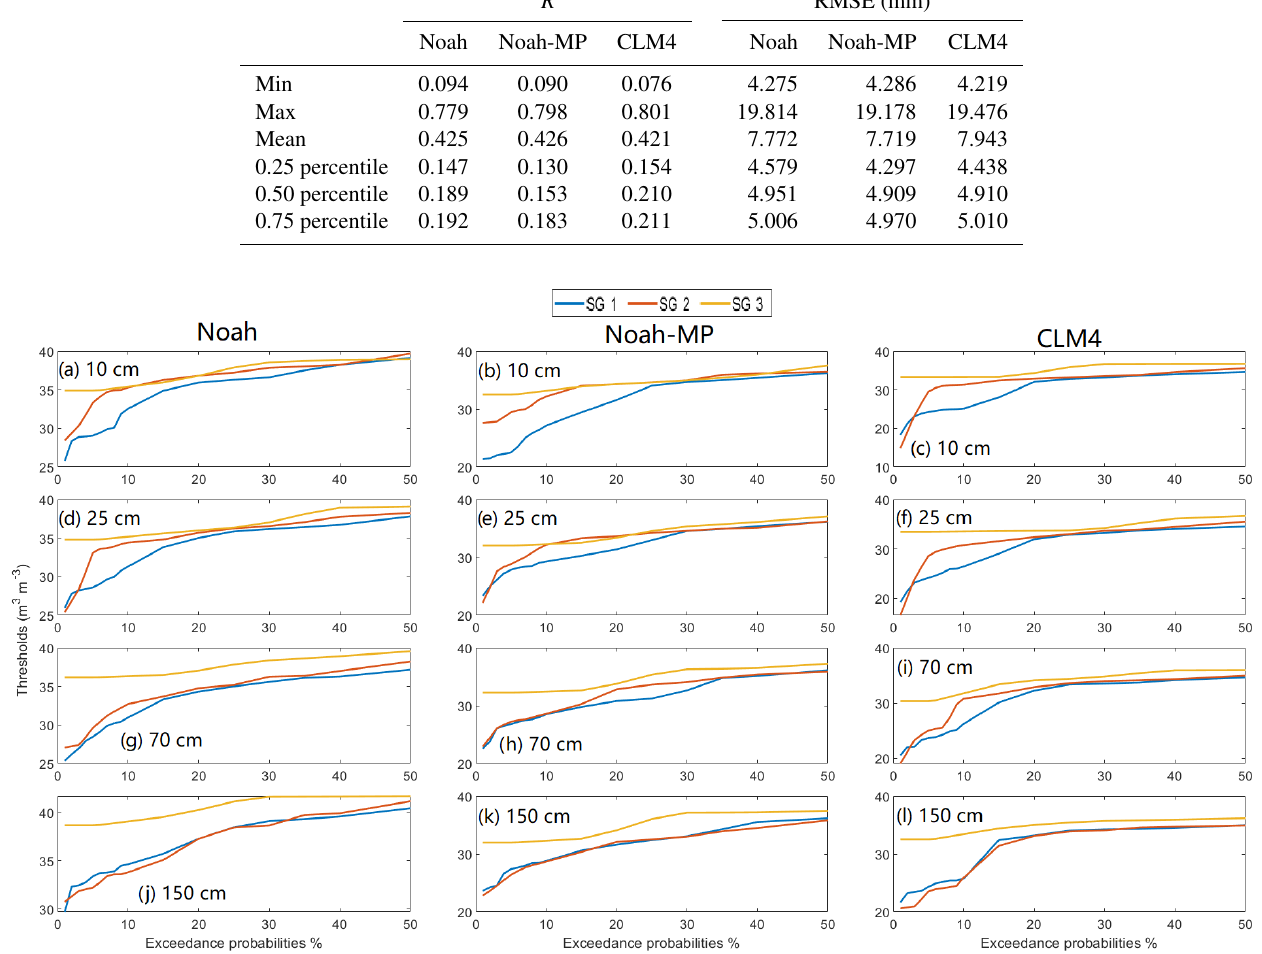
Figure 7. Threshold plots. For Noah (a, d, g, j) , Noah-MP (b, e, h, k) , and CLM4 (c, f, i, l) land surface schemes under three slope angle groups (SGs), with SG 1 = 0.4–1.86 ◦ , SG 2 = 1.87–9.61 ◦ , SG 3 = 9.52–40.43 ◦